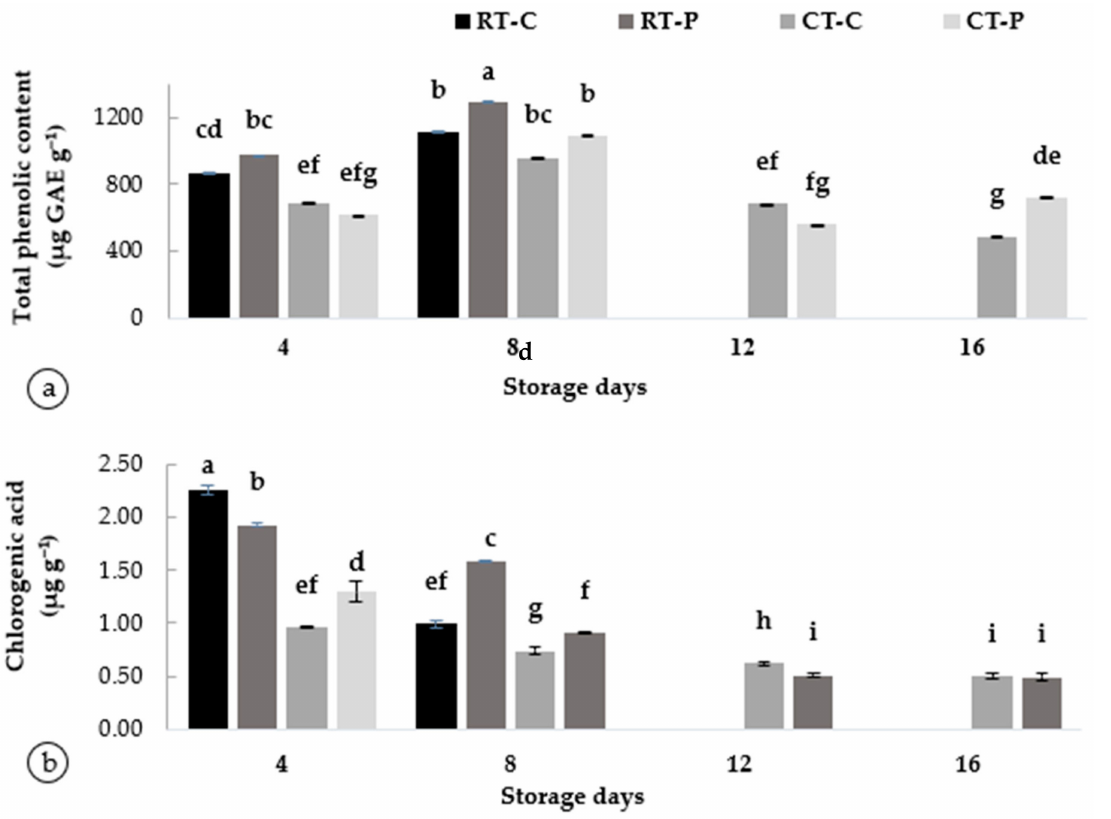
Figure 3. Phytochemical properties: ( a ) TPC and ( b ) TFC associated with browning in Artocarpus odor- atissimus fruit peel. Different superscript alphabets indicate differences at p < 0.05 (ANOVA, Tukey’s test. Abbreviations are as follows: RT-C (room temperature and without packaging/control), RT-P (room temperature and with packaging), CT-C (cool temperature and without packaging/control), and CT-P (cool temperature and with